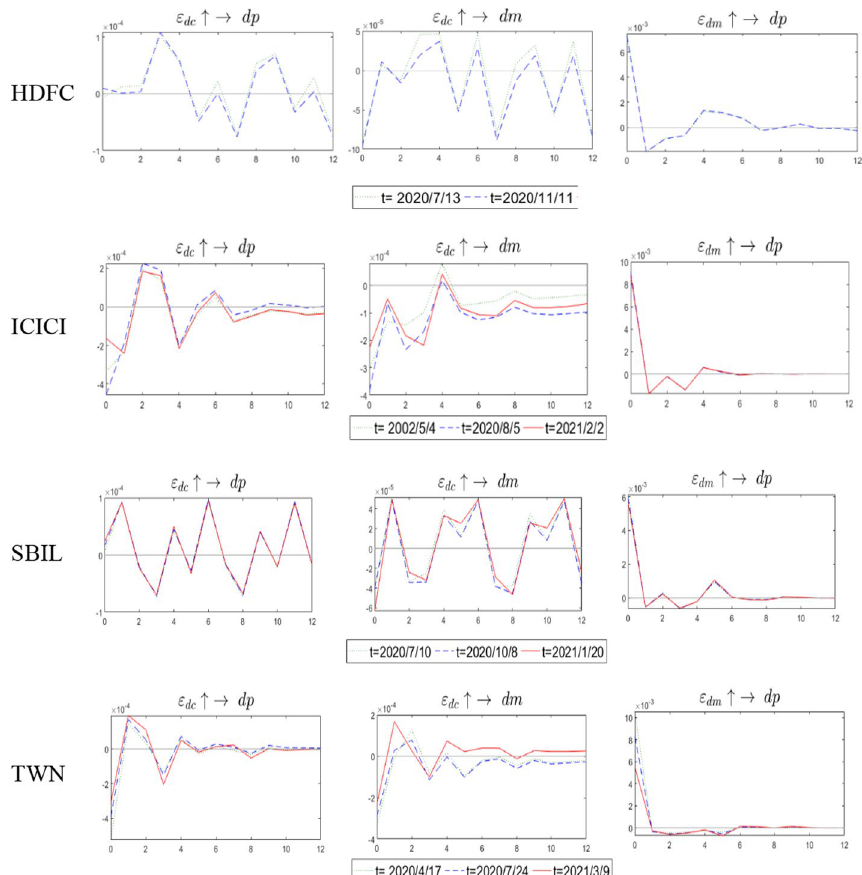
Fig. 4 The Impulse response analysis of TVP‑VAR model at specific structure change